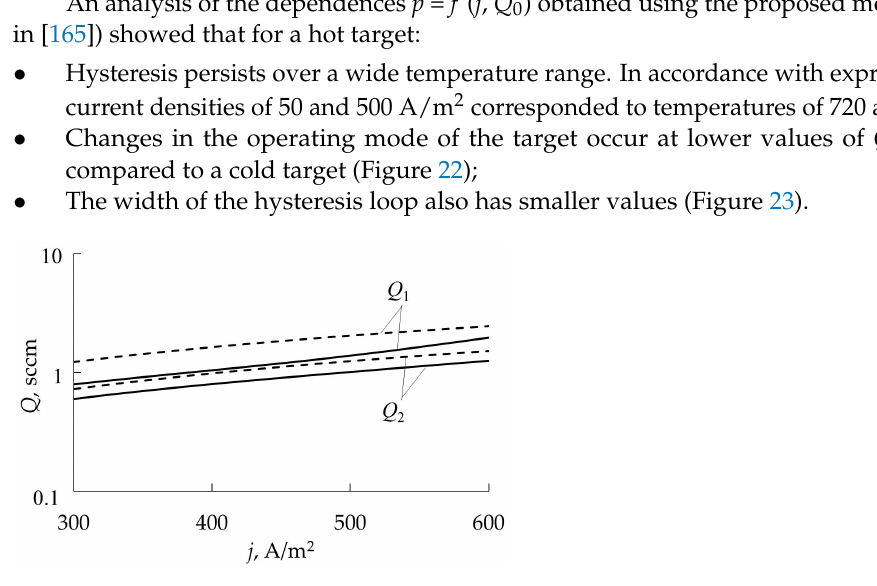
Figure 22. Dependences of the critical values of nitrogen incoming flow on the current density during the transition of the target: Q 01 —from the metallic mode to the nitride one; Q 02 —from the nitride mode to the metallic one (solid lines—hot target, dashed lines—cold target).